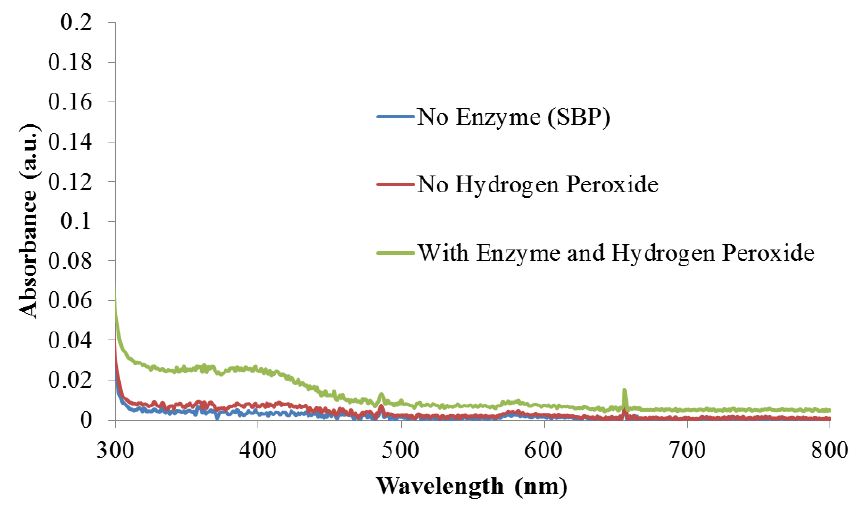
Figure A2. Absorbance spectra monitoring of control reactions with and without SBP and hydrogen peroxide. Measurement recorded from 10 µL reaction sample in 290 µL of solvent system.